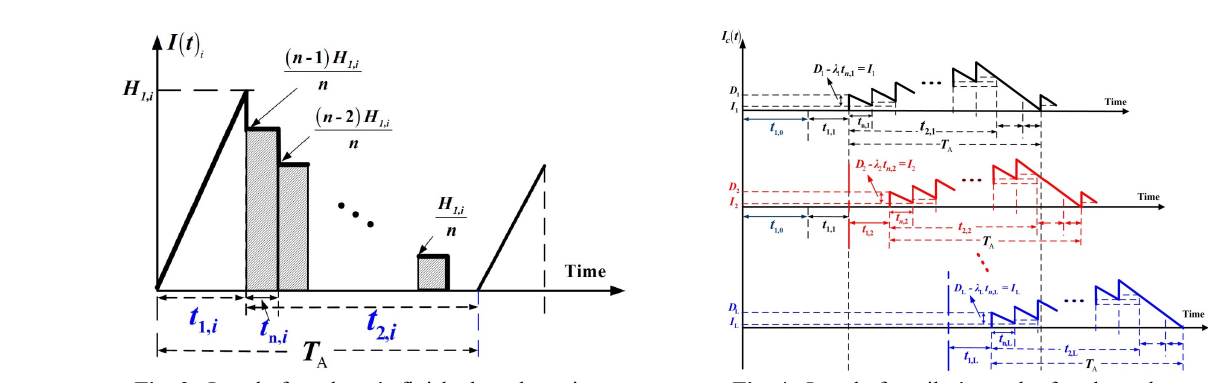
Fig. 3. Level of producer’s finished product i in t 2, i Fig. 4. Level of retailer’s stock of each product